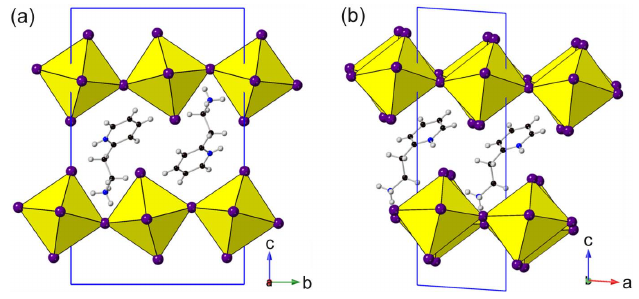
Figure 8 [C 7 H 12 N 2 ]PbI 4 (1944786) showing ( a ) a + / a + tilts around a and ( b ) octahedral distortion (not a tilt) relative to b .